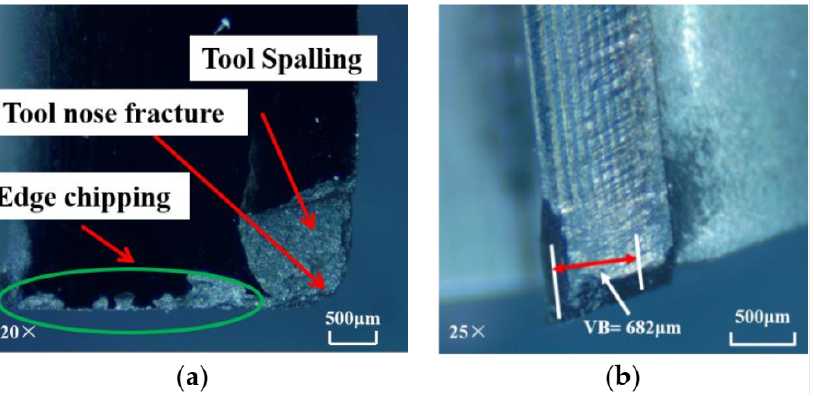
Figure 5. Wear of CVD diamond tool in dry machining: ( a ) rake face; ( b ) flank face (material removal amount = 21 mm 3